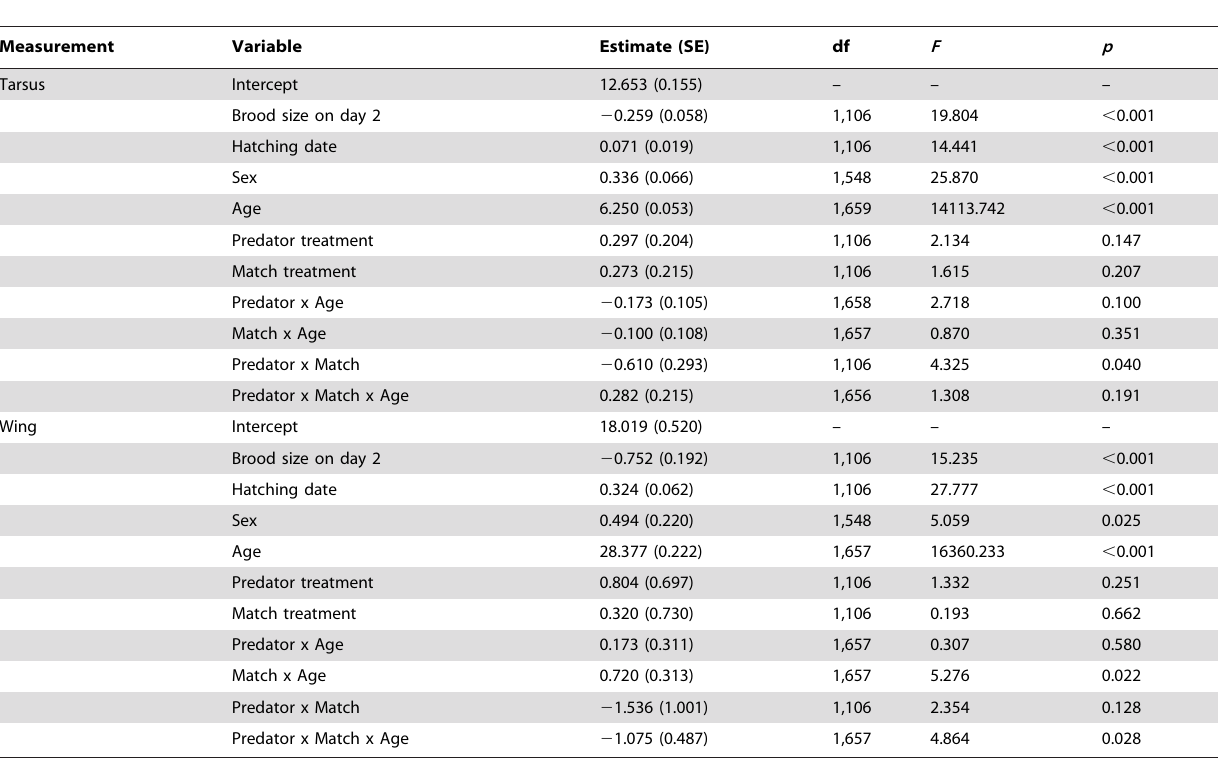
Table 4. ANOVA table and estimated coefficients – linear mixed model for nestling morphological traits.